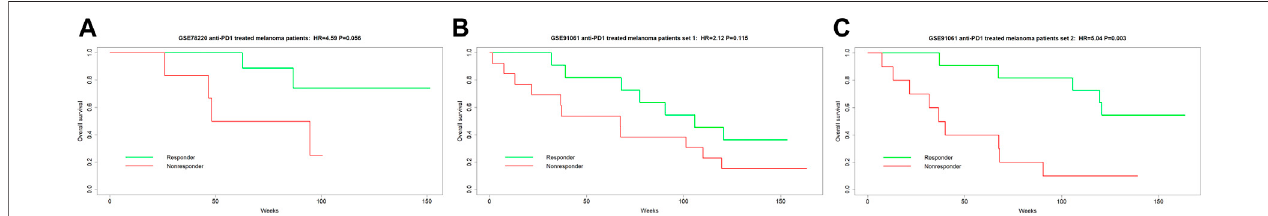
FIGURE 1 | TMEPRE was validated on three datasets of melanoma patients who received anti-PD1 treatment. (1A) n (cid:1) 16, pretreatment samples, patients were treated with pembrolizumab or nivolumab, HR (cid:1) 4.59, p -value (cid:1) 0.056; (1B) n (cid:1) 21, sampling before cycle 1 day 0, patients were treated with nivolumab, HR (cid:1) 2.12, p -value (cid:1) 0.115; (1C) n (cid:1) 21, sampling at an early treatment time point before cycle 1 day 29, patients were treated with nivolumab, HR (cid:1) 5.04, p -value (cid:1) 0.003. Separation of overall survival between TMEPRE-predicted responder group and TMEPRE-predicted nonresponder group is clear in all three validations.